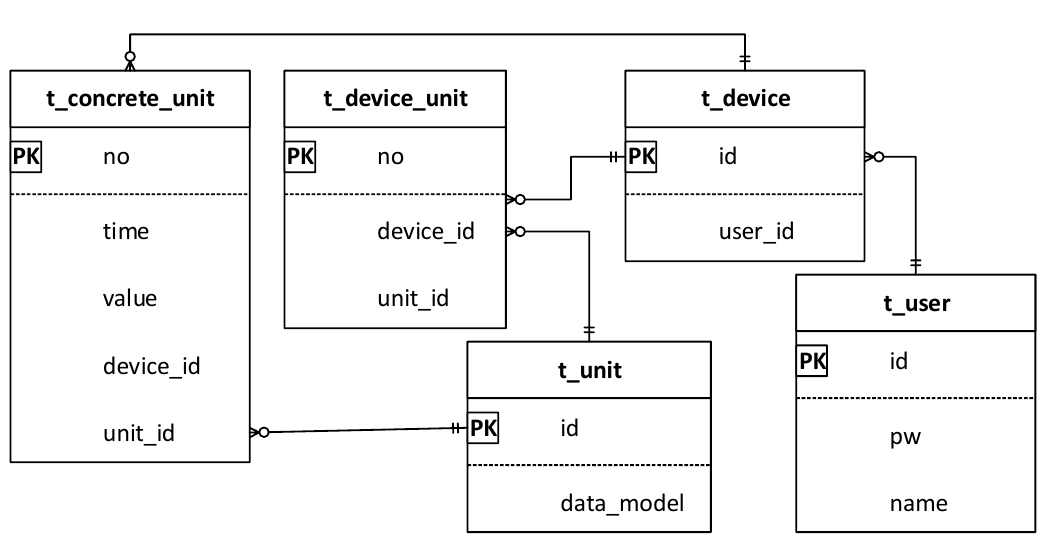
Figure 8. Database ER-diagram of the e-Health system.